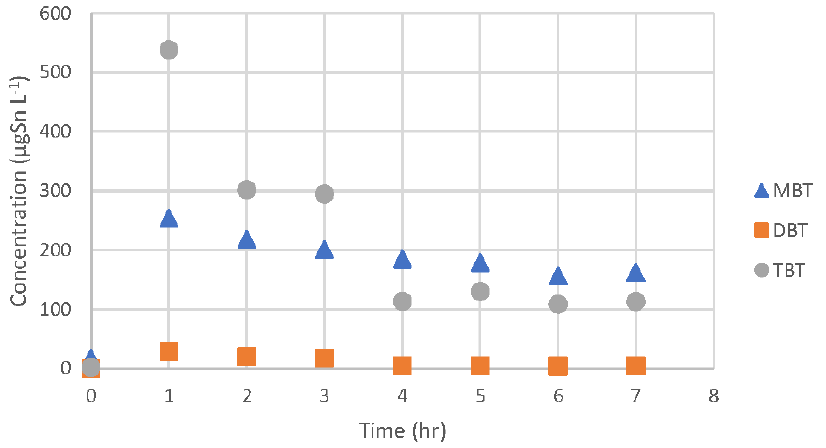
Figure 8. Example of OSn concentration in water during retention kinetic essay with bulk synthe ‐ tized MIP.